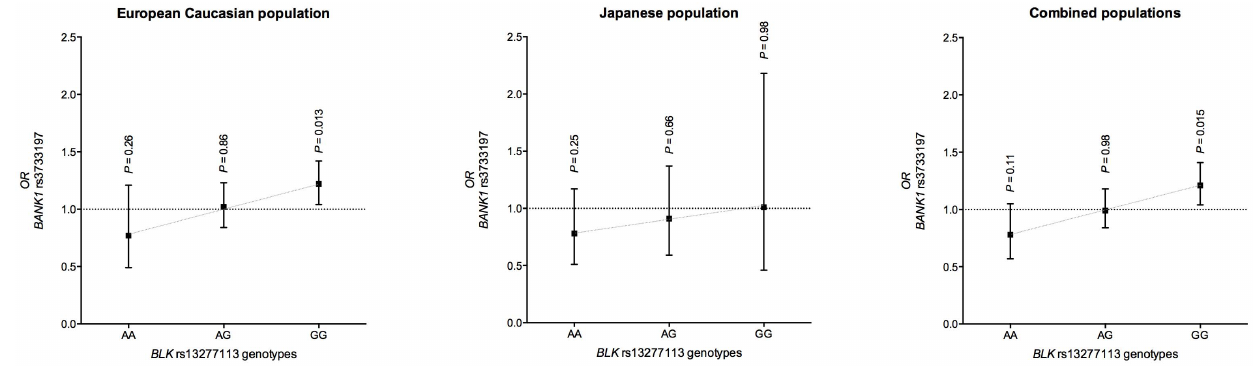
Figure 2. Epistasis between BANK1 rs3733197 and BLK rs13277113. OR for trend for the G allele of BANK1 rs3733197 and the three BLK rs13277113 genotypes by population (France, Spain and Japan).